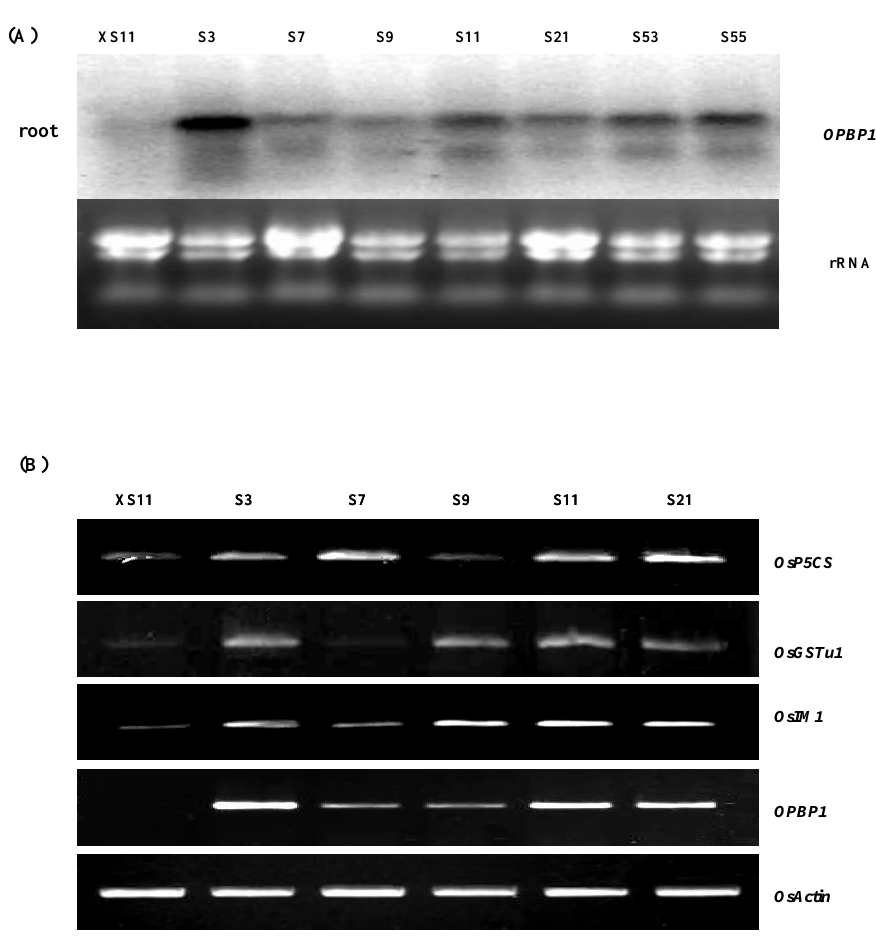
Figure 1. Constitutively expressing OPBP1 and stress-inducible genes in transgenic rice